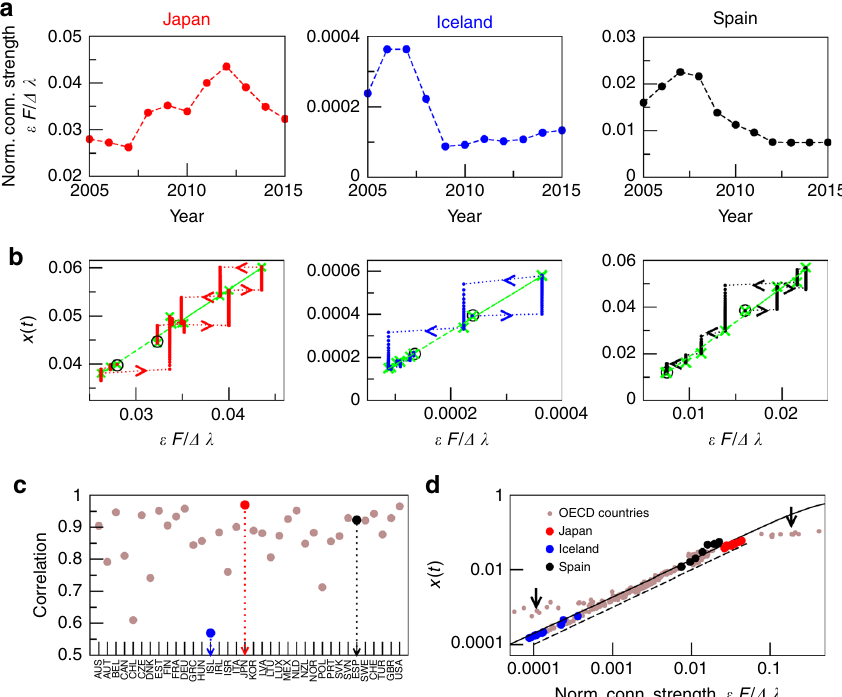
Fig. 4 Analysis of the evolution of the OECD economic network from 2005 to 2015. Data obtained from ref. 37 . a Evolution with time of the normalised connection strength for Japan, Iceland and Spain vs. the rest of the OECD. b Population fl ux diagram for the analysis of the economic behaviour of Japan, Iceland and Spain in their interaction with the rest of the OECD. Crosses represent the equilibria and circles are the initial and fi nal equilibria. c Correlation between the normalised connection strength for every country vs. the rest of the OECD in a year and its precedent, averaged along the 11-years period. d Equilibria for every year (2005 – 2015) and every country in the OECD in the population fl ux diagram — USA and Luxembourg marked with arrows. The black line represents the equilibria of the two scale-free networks studied throughout the paper (already plotted in Fig. 3) and the dashed line represents L = ð λ λ the analytical approximation for such equilibria ( x A ; 1 (cid:2) B ; 1 Þ B ; 1 Pu A ; 1 Þ eq ¼ ð u strength represents the inputs received by a country from the rest of the OECD. Figure 4a plots the evolution of the normalised connection strength for Japan, Iceland and Spain with the rest of the OECD in the 2005 – 2015 period. The population fl ux diagram for the analysis of their economic behaviour is plotted in Fig. 4b.